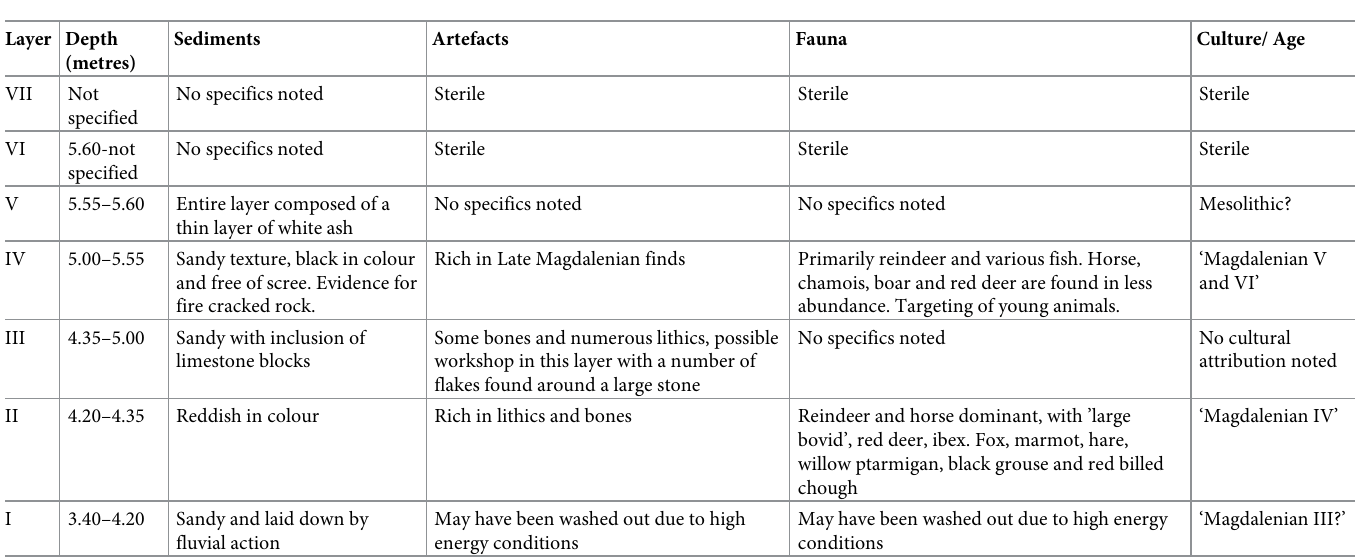
Table summarising the stratigraphy and material culture recorded by Be´tirac. Information derived from [53,